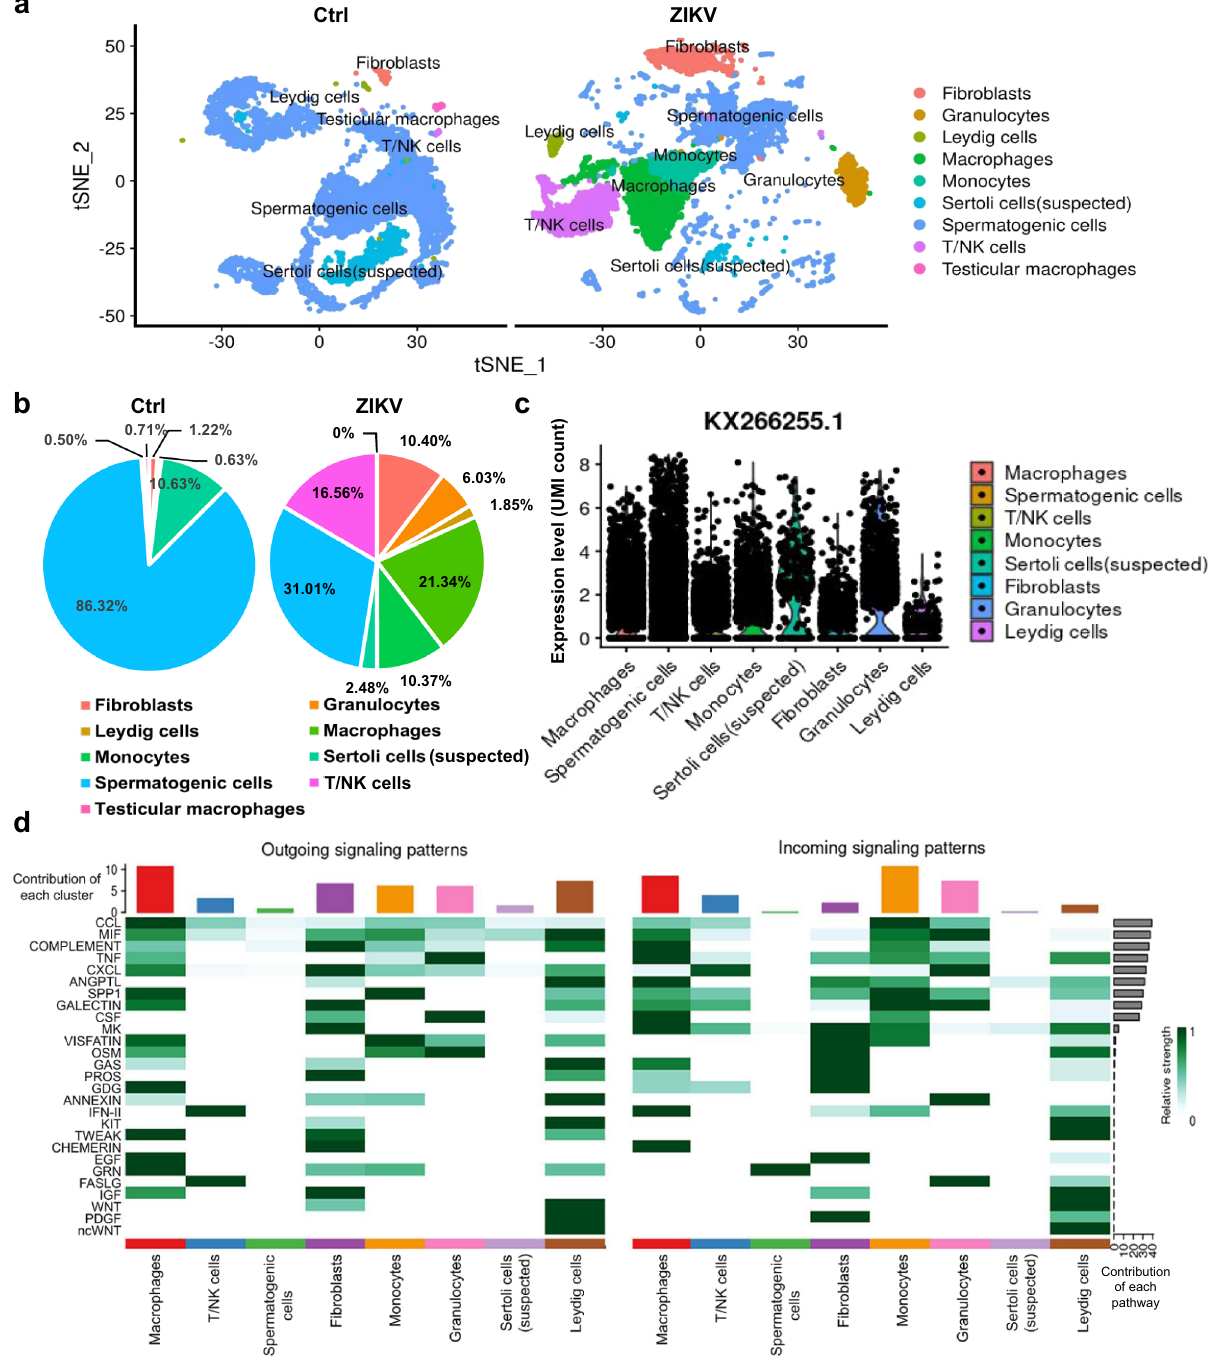
Fig. 1 | Identi fi cation of cell clusters in ZIKV-infected testes. Testes from PBS- injected(control)orZIKV-infectedA6malemiceat14dpiweresubjectedtosingle- cellsequencinganalysis. a Thedistributionofcellclustersinthetestesfromcontrol and ZIKV-infected mice was shown in tSNE chart. b The proportion of each cell cluster in all cells in the testes from control and ZIKV-infected mice was shown in